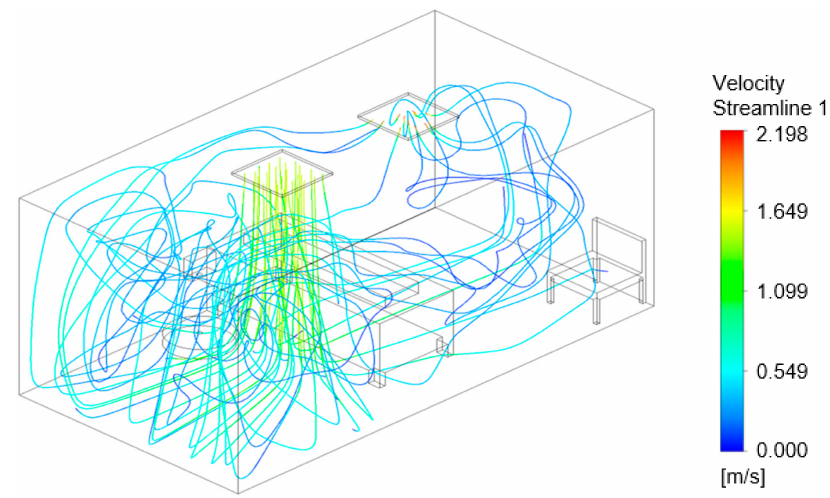
Figure 16. Computational flow model showing airflow velocity streamlines for configuration ‘a’.